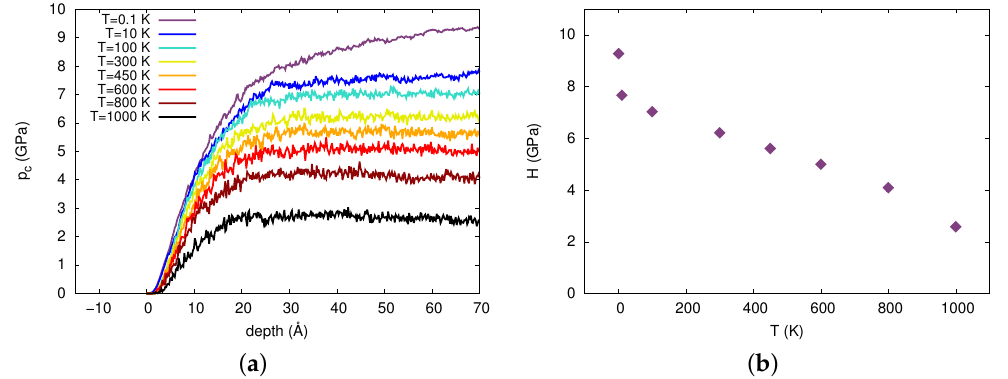
Figure 2. ( a ) Contact pressure as a function of indentation depth obtained for different temperatures. ( b ) Hardness as a function of temperature averaged from the plateau of panel ( a